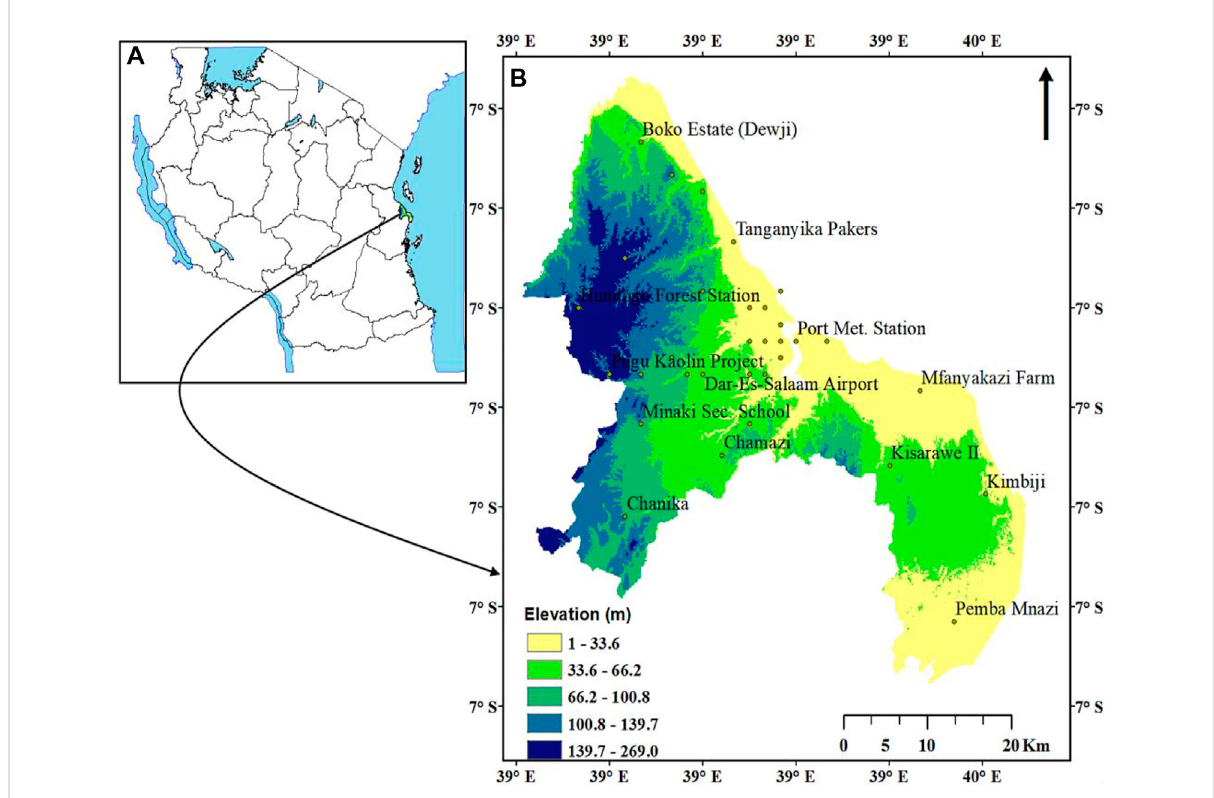
FIGURE 1 The study area map, showing Tanzania (A) and Dar es Salaam region with the location of meteorological stations (B) .